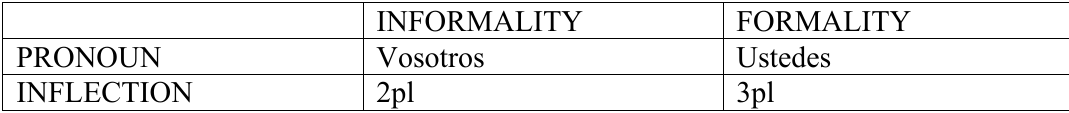
Table 1: Standard 2 nd person plural pronouns system and their